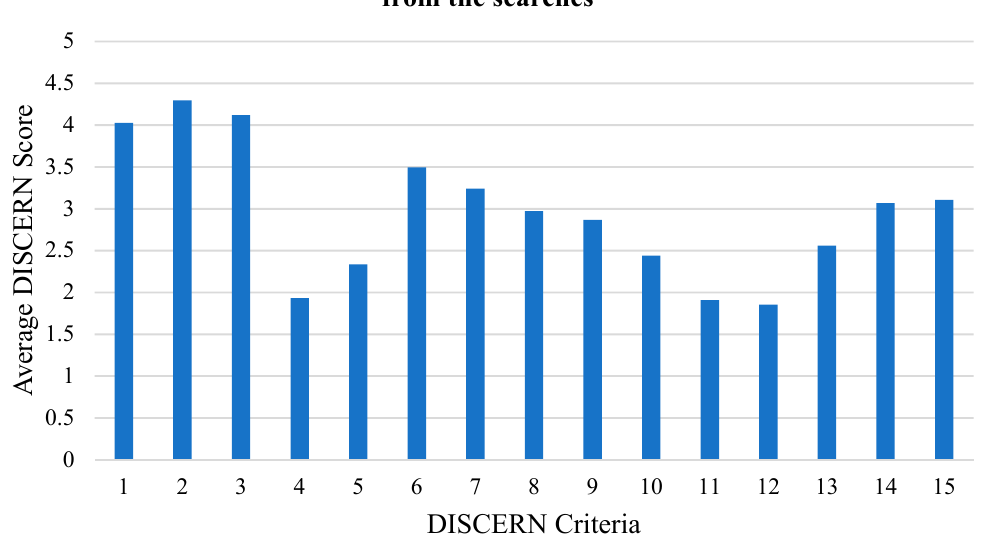
Figure 2. The average score of each of the 15 DISCERN criteria, based on the average of all 75 websites from the searches. Each DISCERN criteria is rated between 1 (does not address) and 5 (does address). The DISCERN criteria definitions can be found in Figure 1.